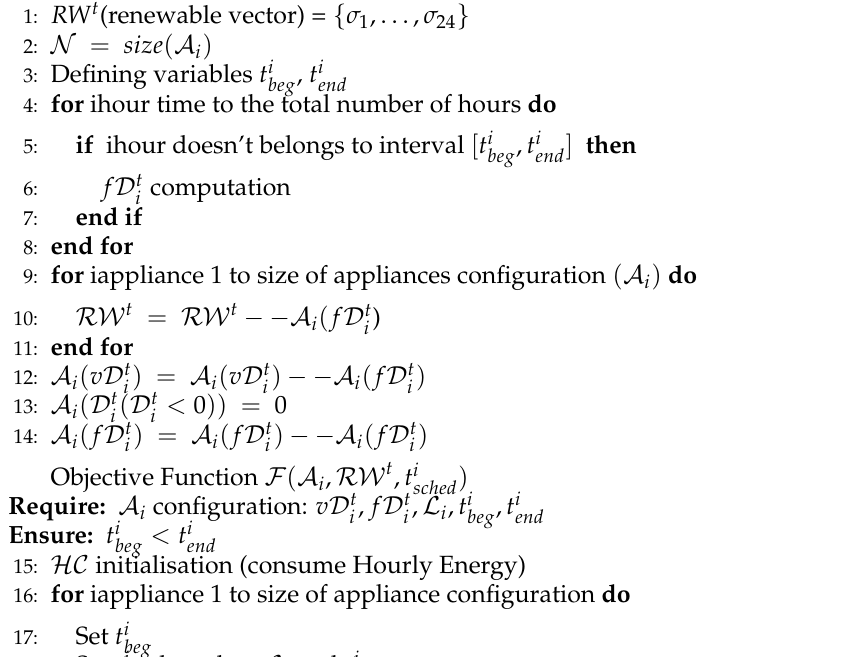
Algorithm 1 Demand Calculation Function ( DCF )